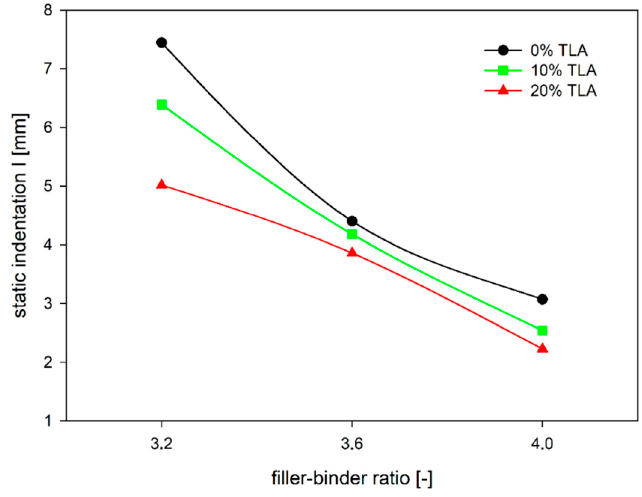
Figure 5. The dependence of MA static penetration on the filler–binder ratio for a different level of TLA addition.